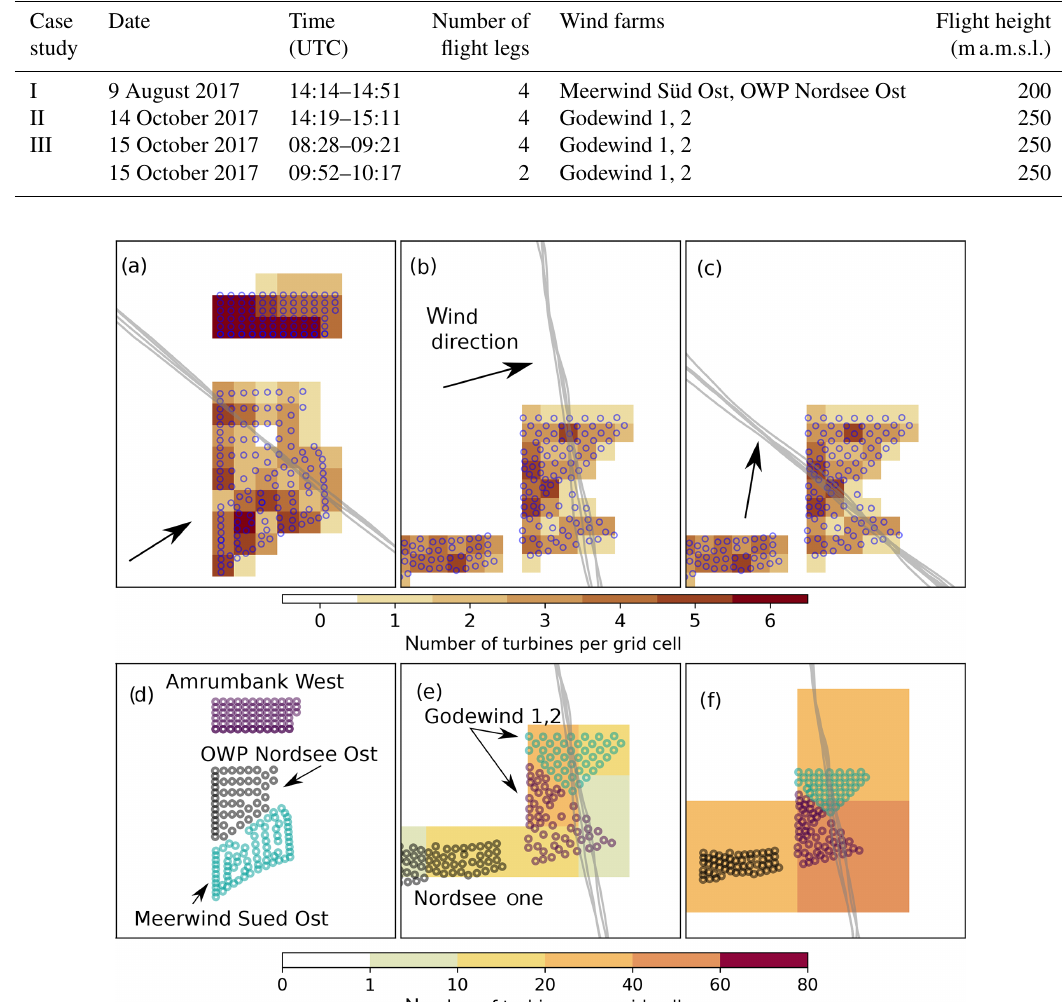
Table 1. Date, time, number of flight legs above the wind farms, location and flight height during the airborne observations.